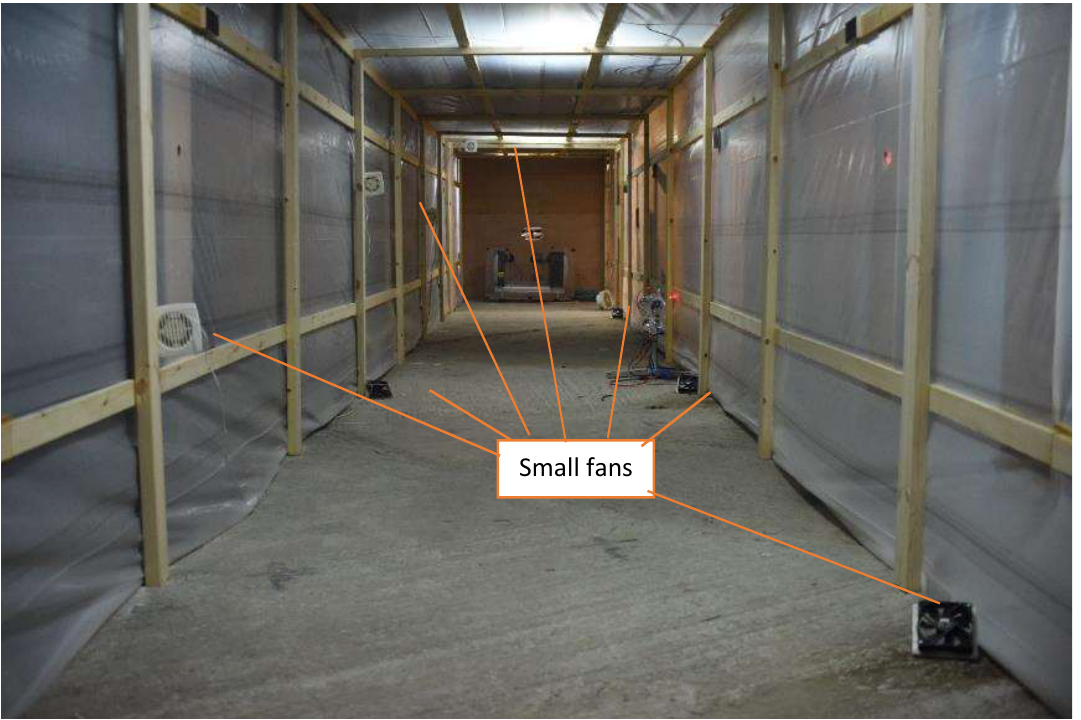
Figure 6. The fog chamber with the small fans used to distribute the fog uniformly.